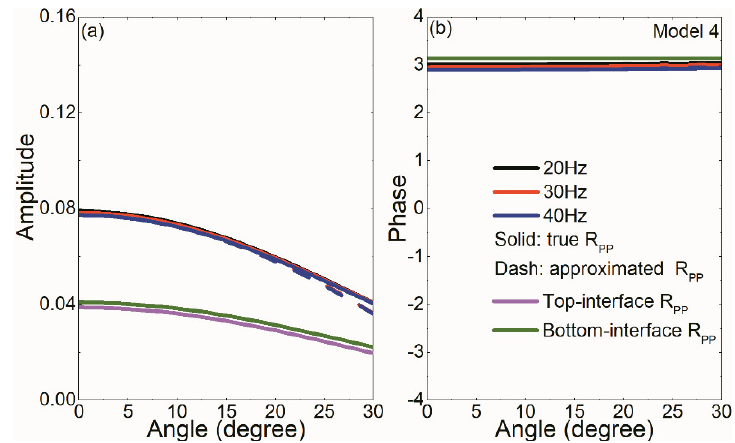
Figure 7. Comparison of Model 4’s R PP calculated by true value and the second-order series approximation, and top-interface and bottom-interface R PP calculated by the Zoeppritz equations, ( a ) amplitude, and ( b ) phase.